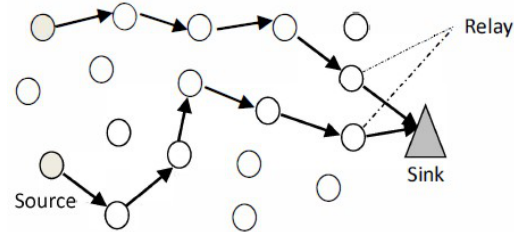
Figure 1. Network Model